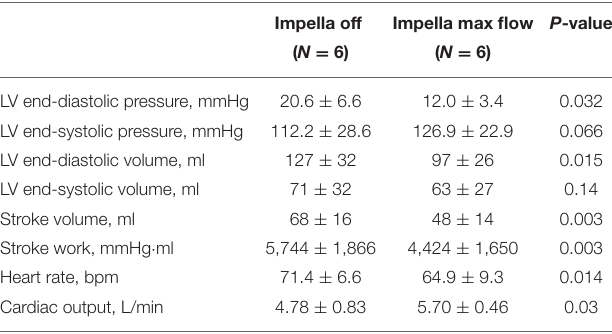
TABLE 2 | Effect of Impella on LV parameters after coronary dissection in animals with large coronary flap. Impella off